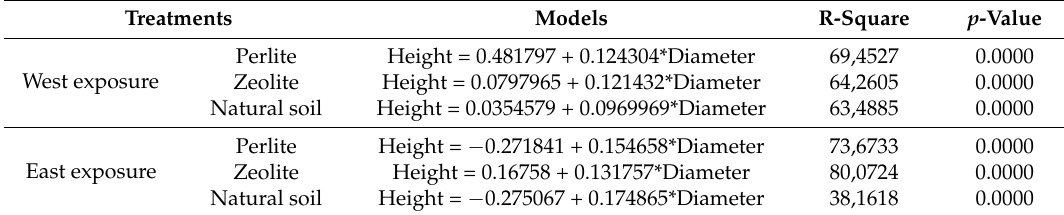
Figure 5. Regressions of growth variables in function of treatments: I . West exposure, II . East exposure, A . Perlite/peat-moss substrate, B . Zeolite/peat-moss substrate, C . Natural soil substrate. Table 3. Mathematical models and significance of treatments.